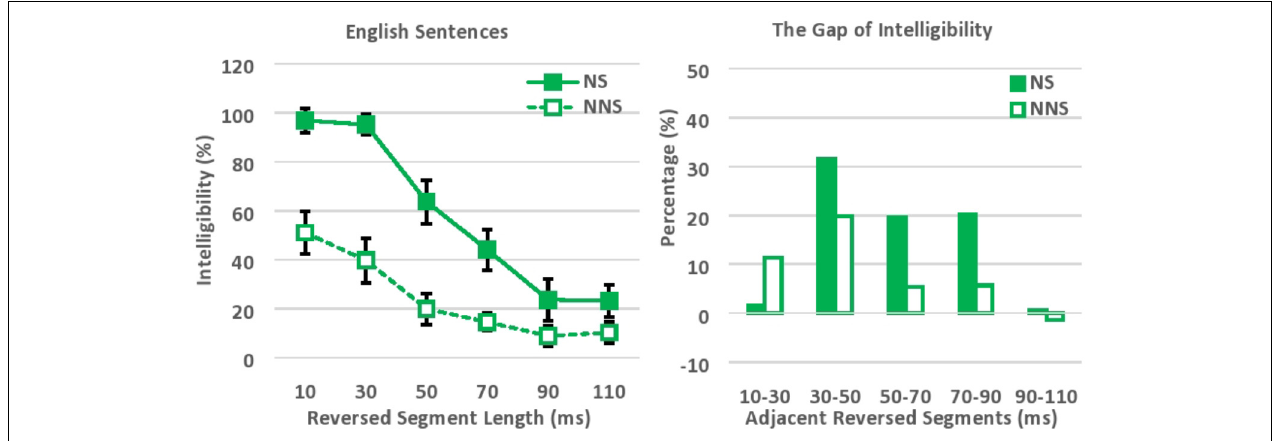
FIGURE 2 | Intelligibility of locally time-reversed English sentences (left) , and the gap of intelligibility between adjacent reversed segment lengths (right) . NS, Native speakers of English; NNS, Non-native speakers of English (native Japanese speakers who speak English as a second language).